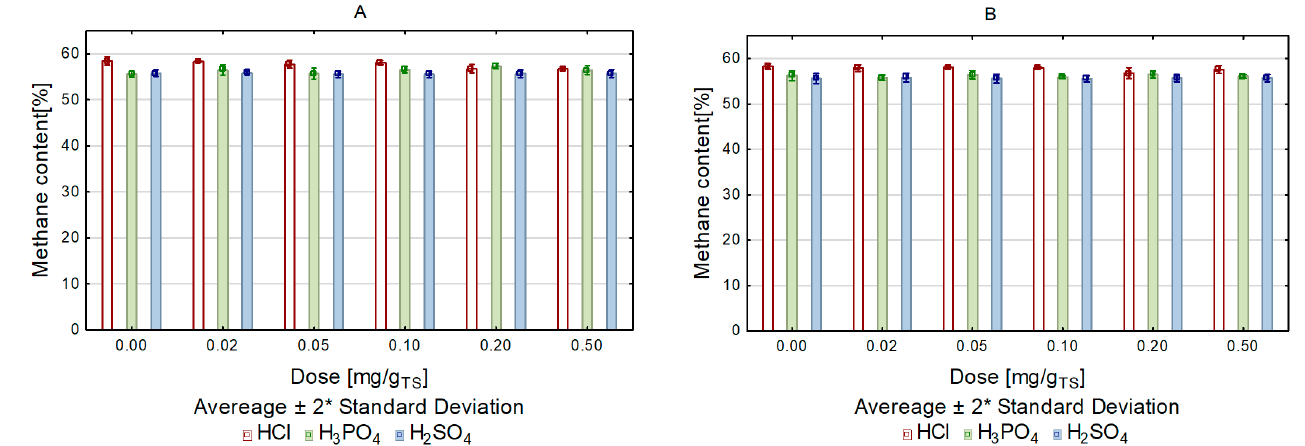
Figure 4. Methane content of biogas, depending on heating method and acid dose (( A )—conventional, ( B )—microwave).